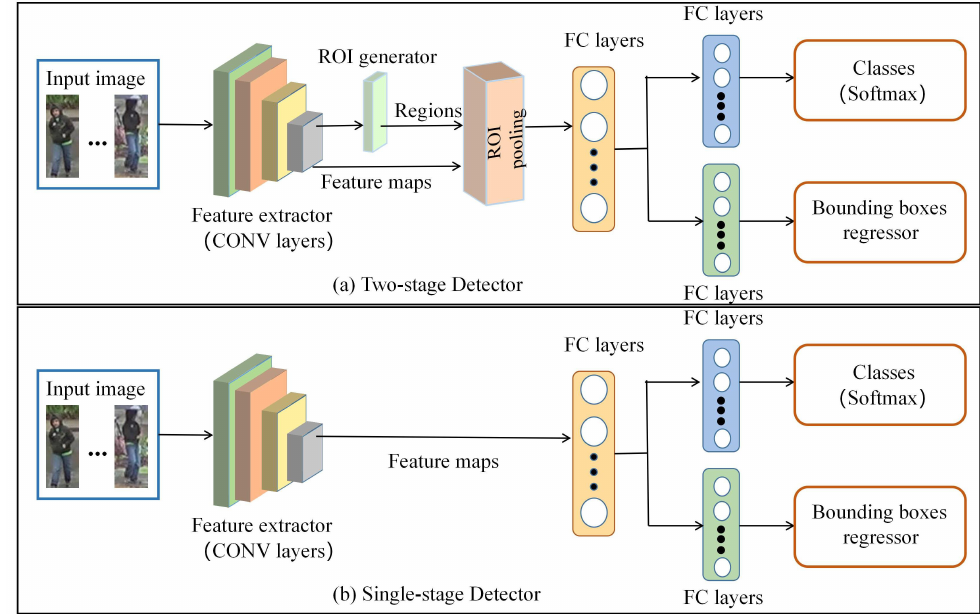
Figure 4. Two-stage vs. Single-stage object detector